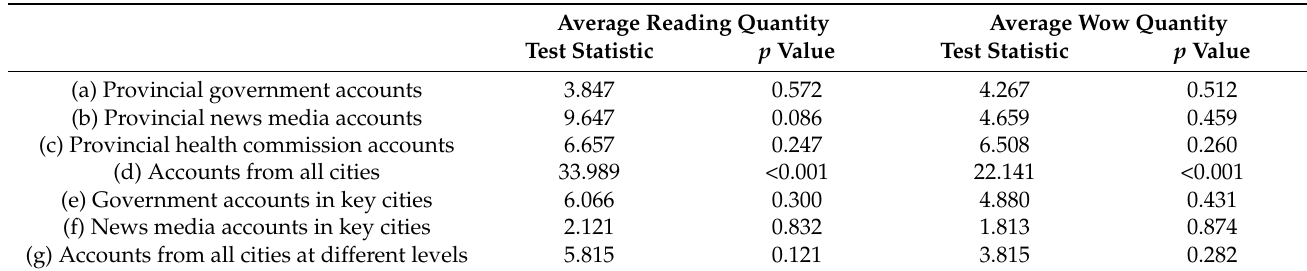
Table 2. Statistical analysis of risk communication